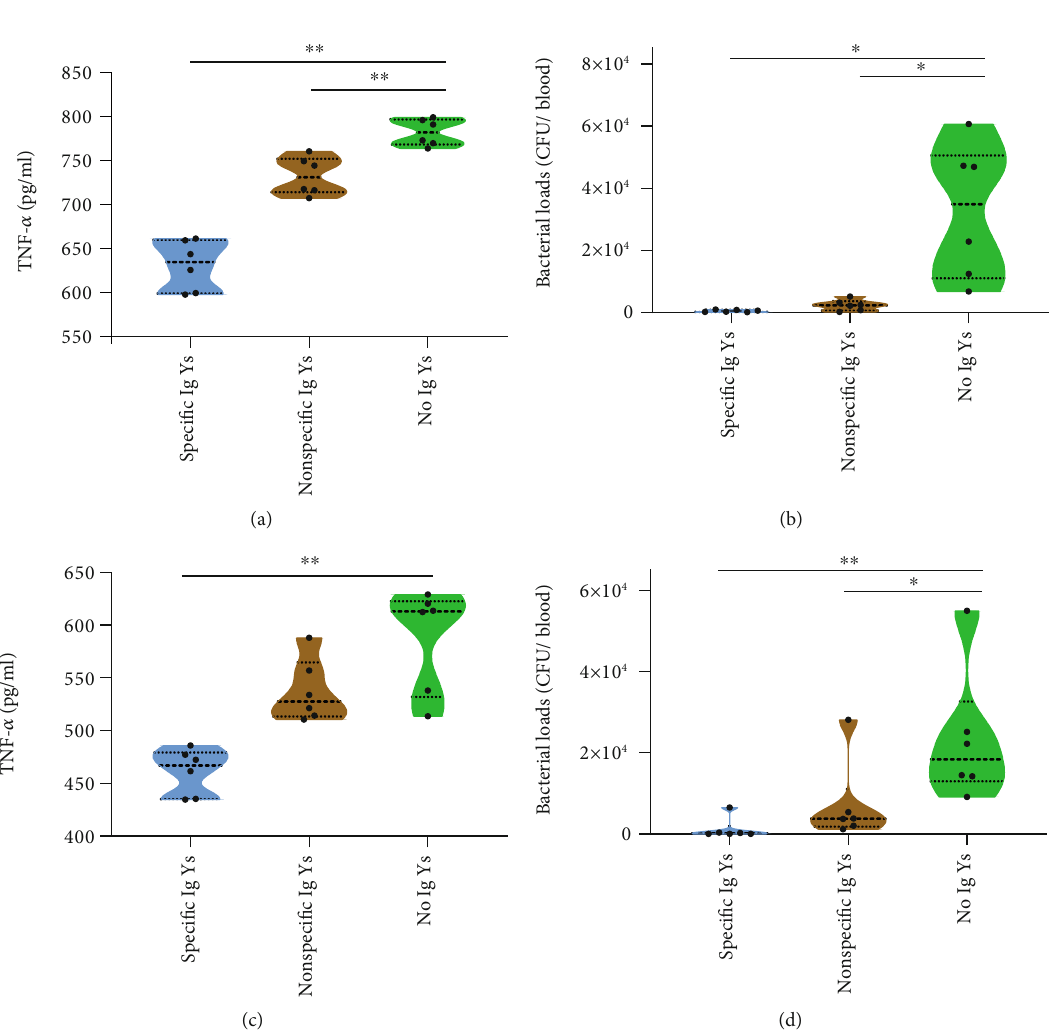
Figure 3: The e ff ects of IgYs against V. vulni fi cus infection on intraperitoneal lavage fl uid TNF- α levels and on blood bacterial loads in both the prophylactic (a, b) and therapeutic (c, d) mouse models ( n = 6 ) ∗ p < : 0 : 5 , ∗∗ p < 0 : 01